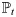
Dynamics of the system with time delays (Δ1, Δ2) in inhibition of TANs.(A) Time courses of concentrations of two main variables (C, I) in the absence (ODE, red) and presence (DDE, blue) of time delays (Δ1 = 1.0, Δ2 = 1.2). (B) Trajectories of solutions (C(t), I(t)) in the C − I plane corresponding to (A). Time delays can push the Pt-phase to the Pa-phase. (C) Time courses of the tumor volumes corresponding to (A, B). Time delays can slow down the tumor size by the N1 to N2 transition in (B). (D) Normalized tumor sizes for various strengths of the two time delays (Δ1, Δ2). Parameters: S = 0.2, G = 0.4. All other parameters are fixed as in Table 2. Initial condition: T(0) = 0.2, C(0) = 1.2, I(0) = 0.5.